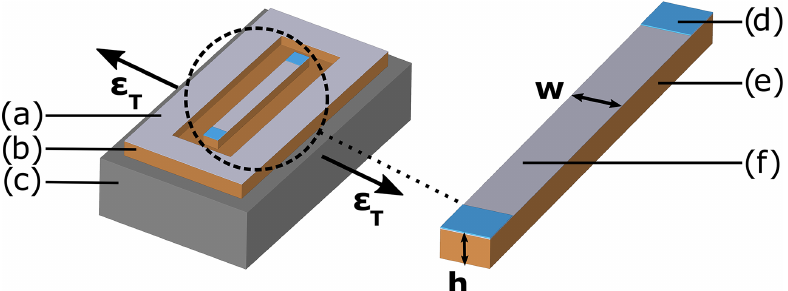
Figure 1. Model of an SG that allows for the strain transfer from the metal component to the active thin film to be influenced; the (a) granular thin film, (b) polyimide carrier, (c) transversally strained metal component, (d) solder pad, (e) polyimide path with height h and width w , and (f) active granular thin film element are shown.